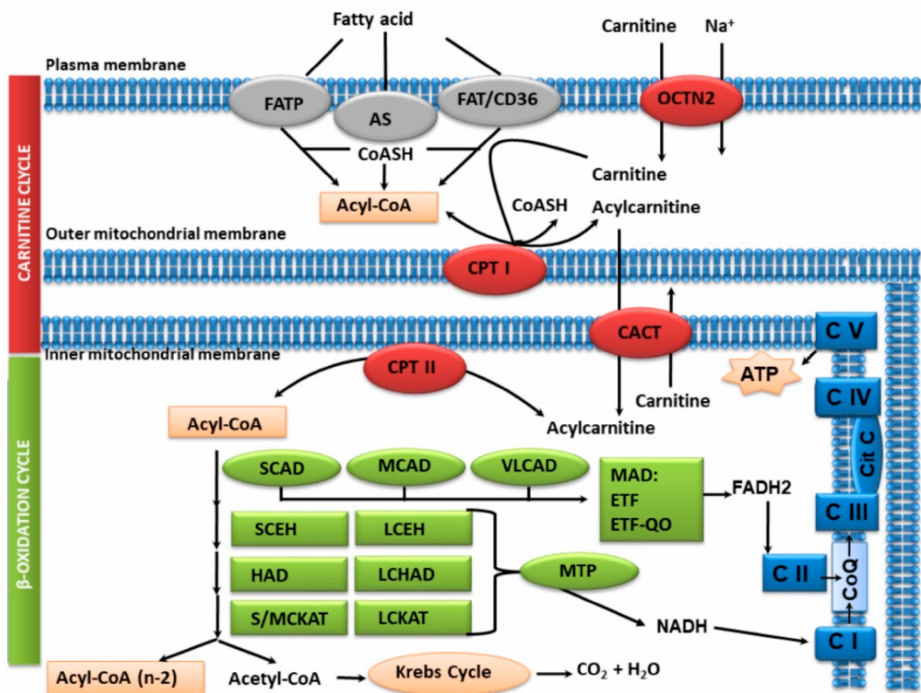
Figure 1. Main stages in carnitine and fatty acid ß-oxidation cycle. Uptake and activation of FA, in gray: FATP, FAT/CD36: fatty acid transporters; AS: acyl-CoA synthetase; Cycling of carnitine to pass the FA to the mitochondrial matrix, in red: OCTN2: carnitine transporter; CPT I: carnitine palmitoyltransferase I; CACT: carnitine-acylcarnitine translocase; CPT II: carni- tine palmitoyltransferase II; β -Oxidation spiral, in green: SCAD: short-chain acyl-CoA dehydro- genase; MCAD: medium-chain acyl-CoA dehydrogenase; VLCAD: very long-chain acyl-CoA de- hydrogenase; SCEH: short-chain enoyl-CoA hydratase; LCEH: long-chain enoyl-CoA hydratase; HAD (M/SCHAD): 3-hydroxyacyl-CoA dehydrogenase; LCHAD: long-chain 3-hydroxyacyl-CoA dehydrogenase; S/MCKAT: short/medium-chain 3-ketoacyl-CoA thiolase; LCKAT: long-chain 3-ketoacyl-CoA thiolase; MTP: mitochondrial trifunctional protein; MAD: multiple acyl-CoA de- hydrogenase; Electron transfer and respiratory chain pathway, in blue: CoQ, CI, CII, CIII, CIV, CV: coenzyme Q and mitochondrial respiratory complexes I, II, III, IV and